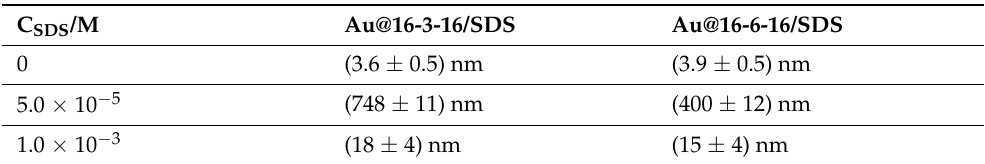
Table 2. Values of the hydrodynamic diameters of different Au@16-s-16 nanoparticles and Au@16-s- 16/SDS structures.